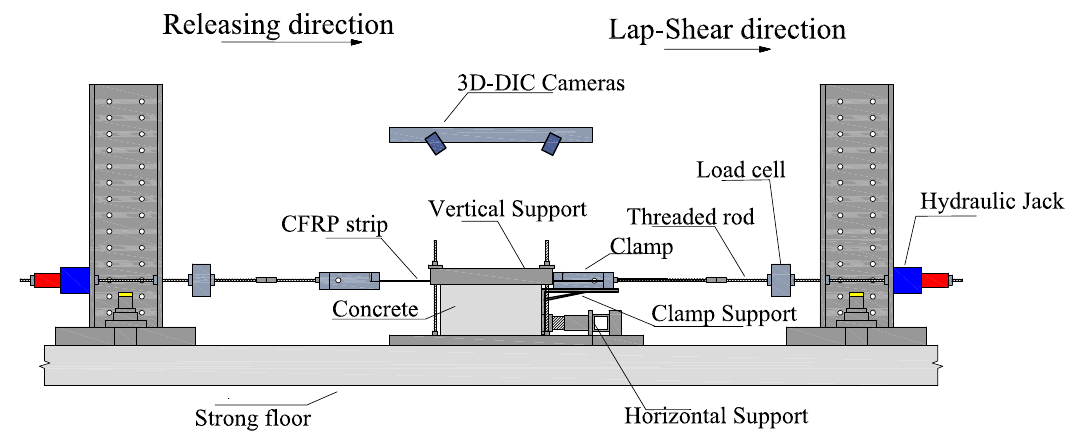
Figure 6. Schematic description of the lap-shear test setup and its key components. Adopted and modified from Michels et al. (2014) [24].